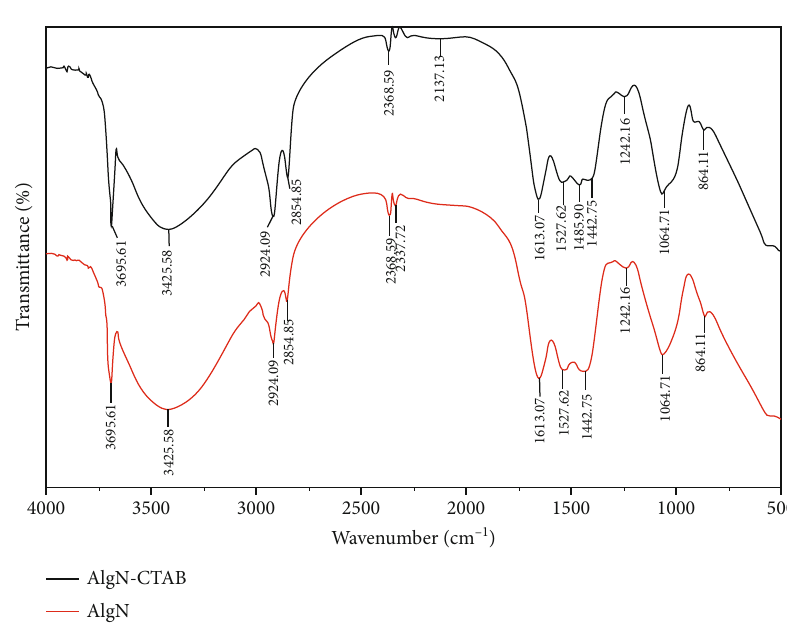
Figure 2: IR spectra of AlgN and AlgN-CTAB.